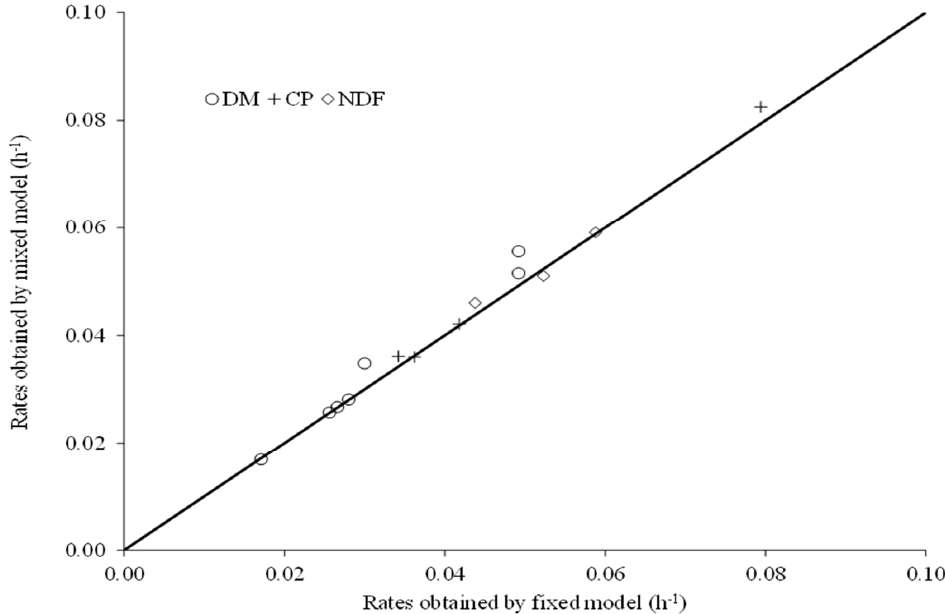
Figure 2. Relationship between degradation rates (DM, dry matter; CP, crude protein; NDF, neutral detergent fiber) of different feeds estimated by the fixed or mixed nonlinear modelling approaches [ Ŷ = − 0.00007 – 1.037 × X; r 2 = 0.98; s XY = 0.002; p value ( β 0 = 0): 0,964; p value ( β 1 = 1): 0.342; the continuous line represents the relation of equality].